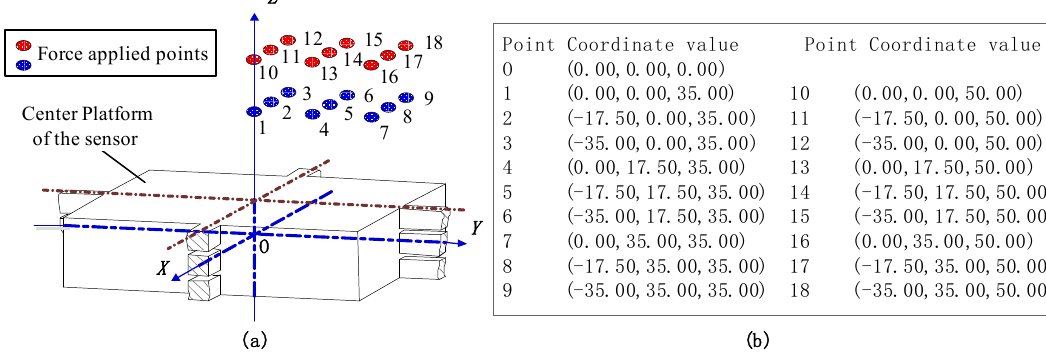
Figure 6. ( a ) The 18 points where force was applied for calibration testing; ( b ) the detailed coordinate values.